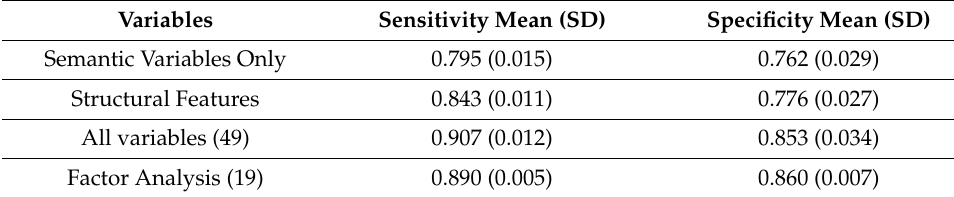
Table 8. Mean and SD of Sensitivity and Specificity of Binary Classifiers.